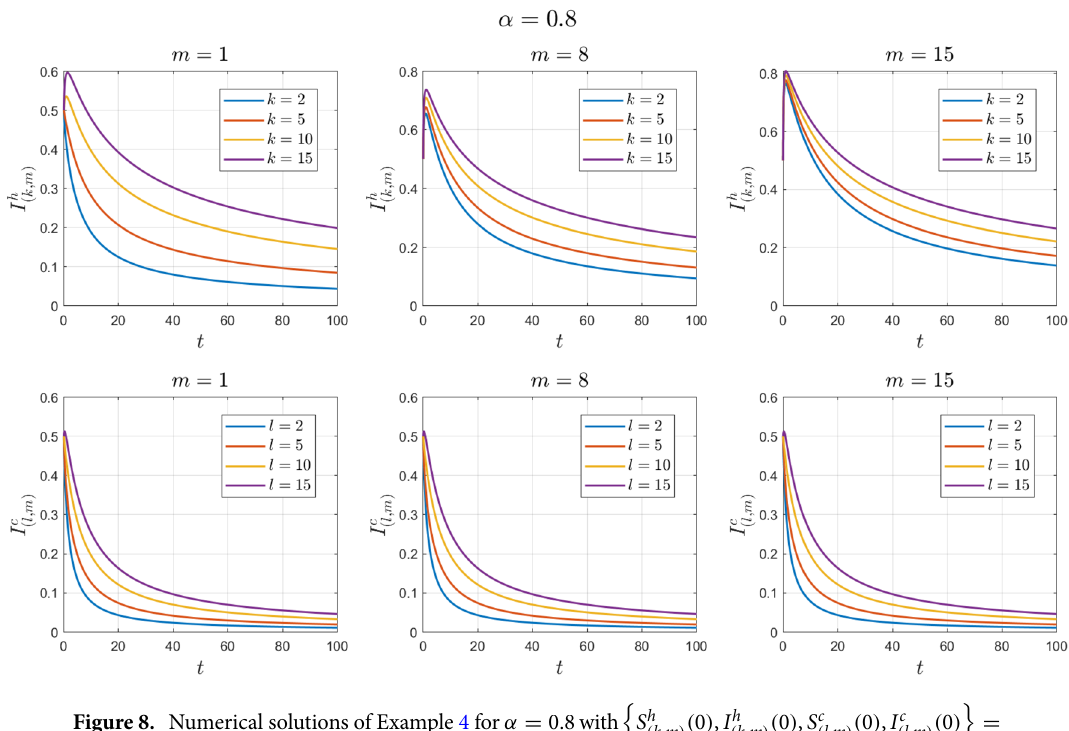
Figure 8. Numerical solutions of Example 4 for α = 0.8 with { 0.5, 0.5, 0.5, 0.5 } .